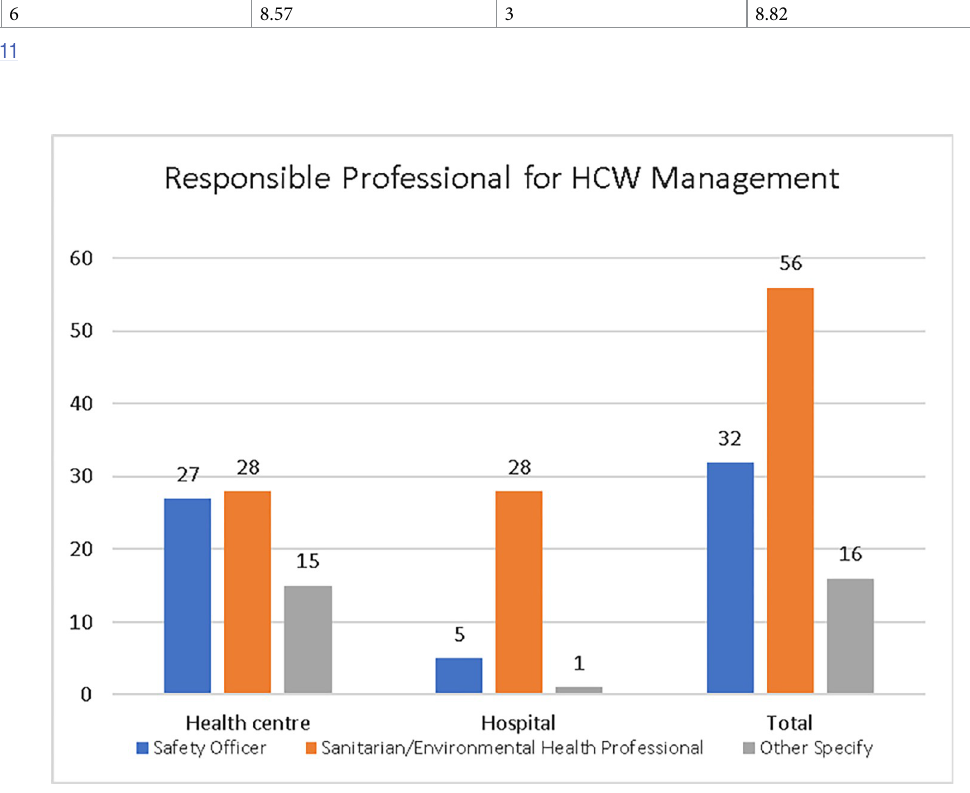
Fig 7. Responsibility for HCW management in the study health facilities, Addis Ababa City Administration, February 2018.